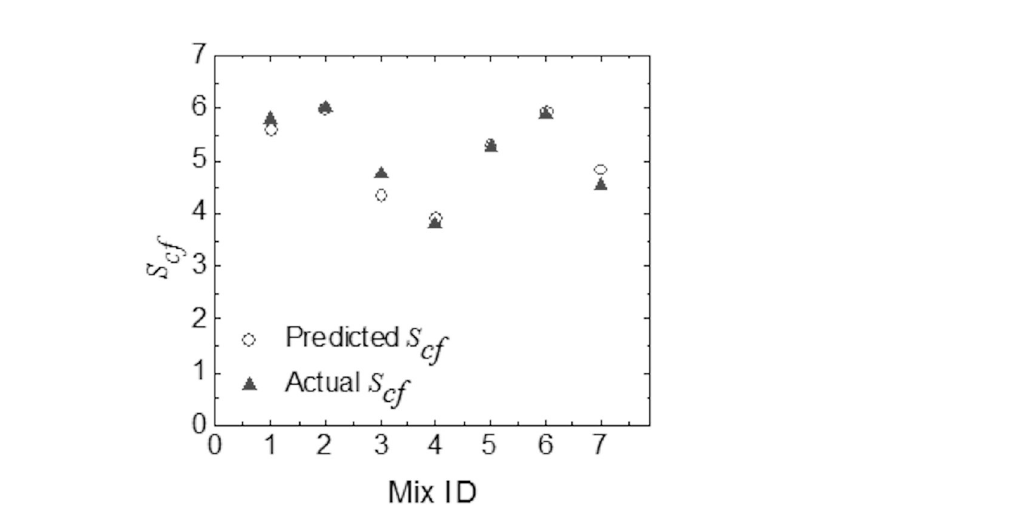
Figure 4. Actual (experimentally measured) shear stress concentration factor ( S cf ) is compared with that of the new model